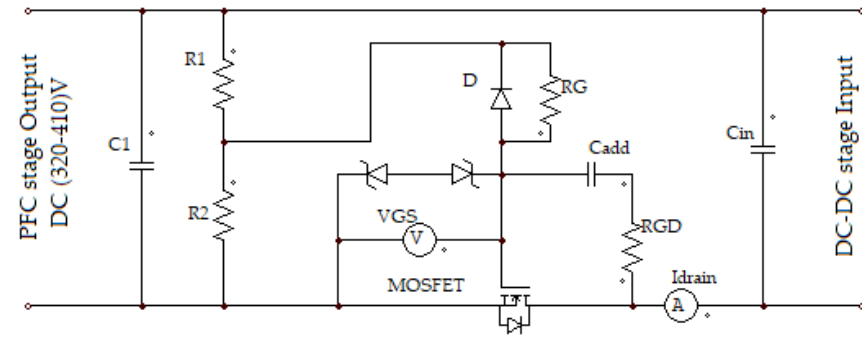
Figure 4. Proposed inrush current controlling circuit.